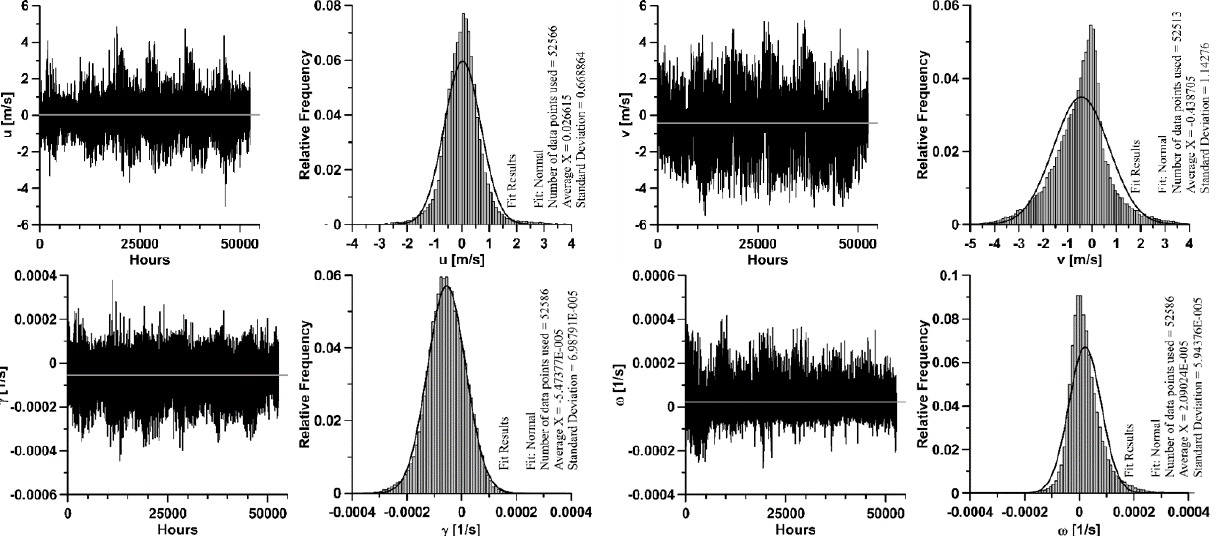
Figure 5. Schematic illustration of the mean wind circulation mode in Mexico City